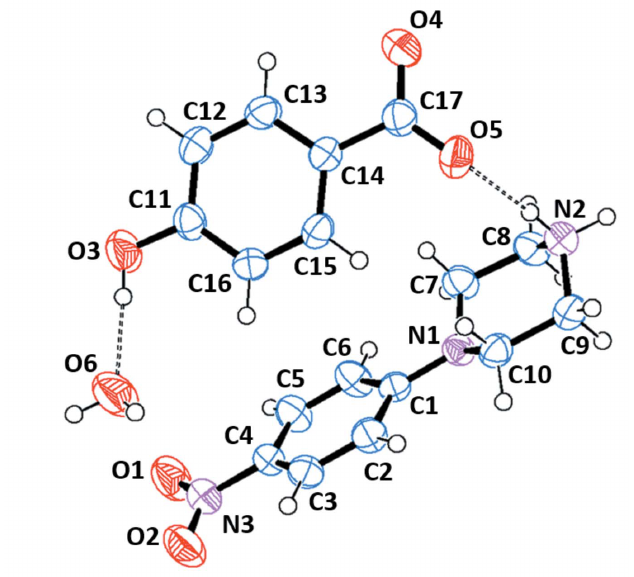
Figure 3 The independent components of compound (III) showing the atom- labelling scheme and the hydrogen bonds, drawn as dashed lines. Displacement ellipsoids are drawn at the 50% probability level.